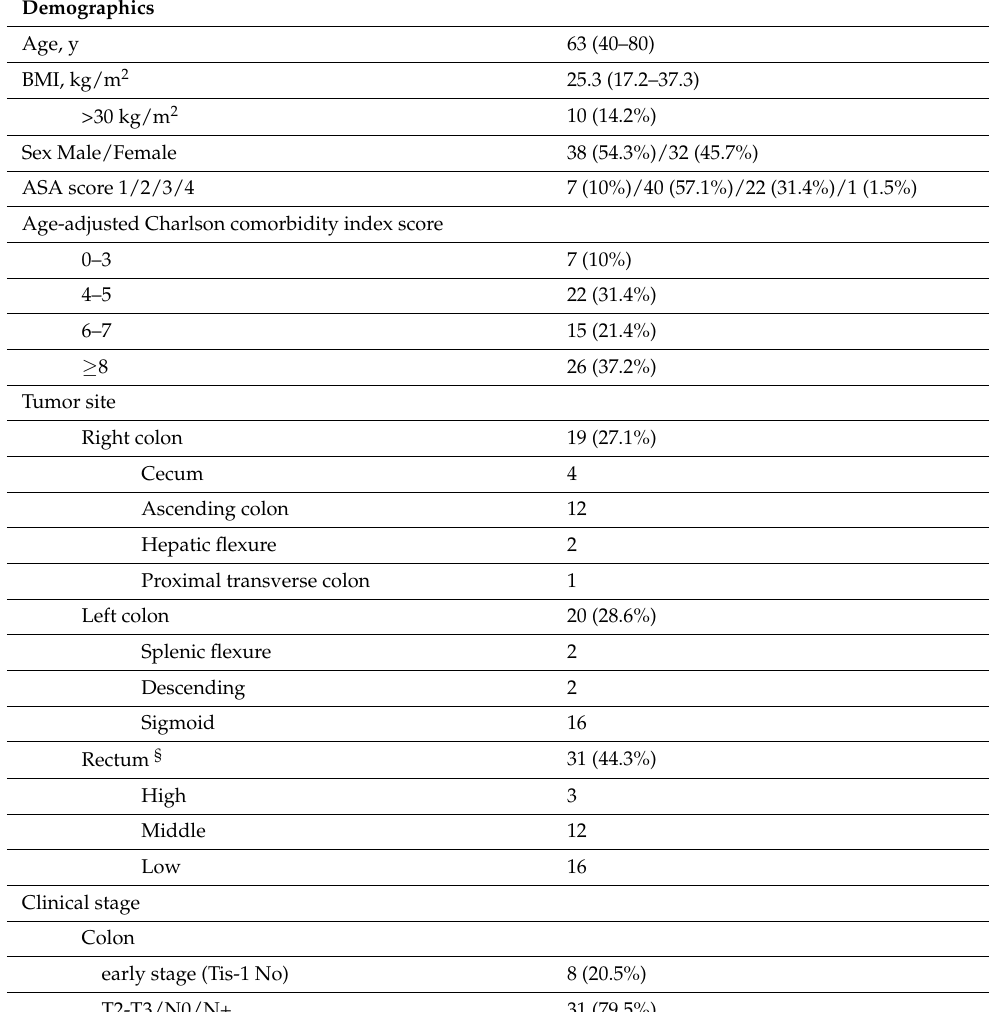
Table 1. Baseline